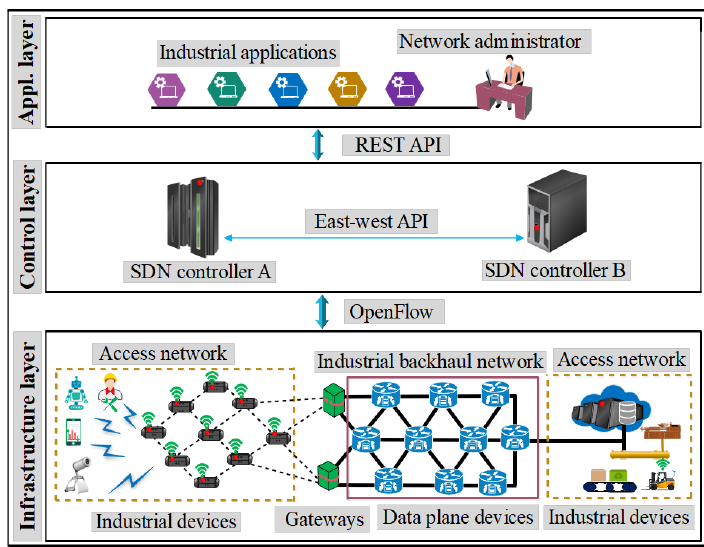
Figure 4. ISDN resilience